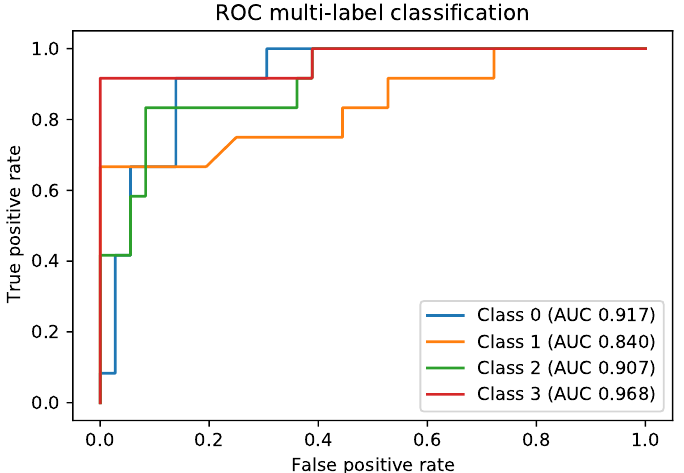
Figure 6. ROC curves for the multiple label classification for the fine-tuned ensemble. Each curve is calculated using a one versus the rest